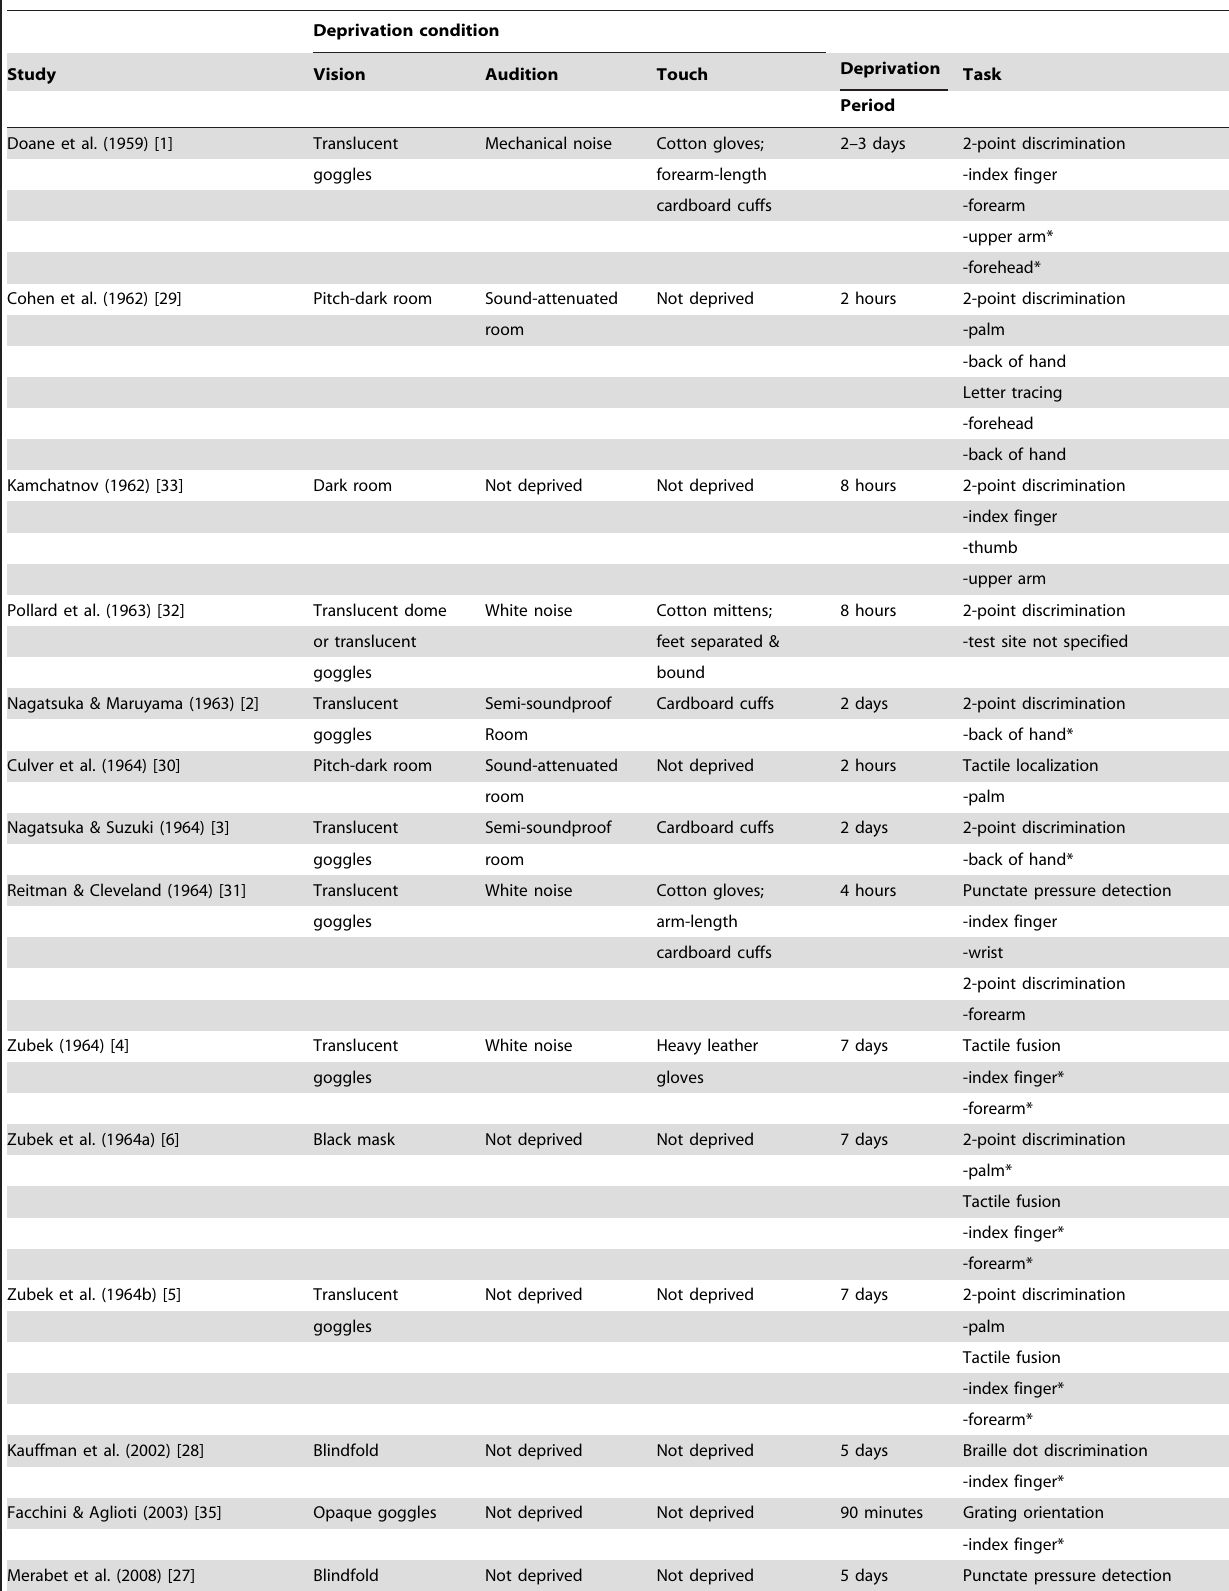
Table 1. Summary of visual/multisensory deprivation studies since